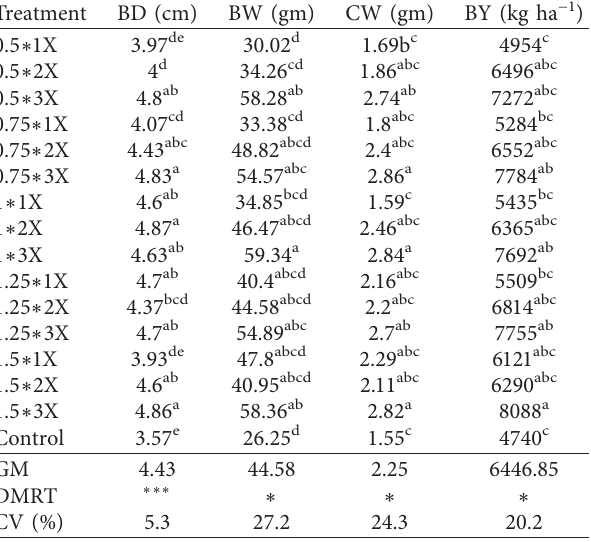
Table 5: The mean of garlic bulb yield and yield component data at Segno in 2019 cropping